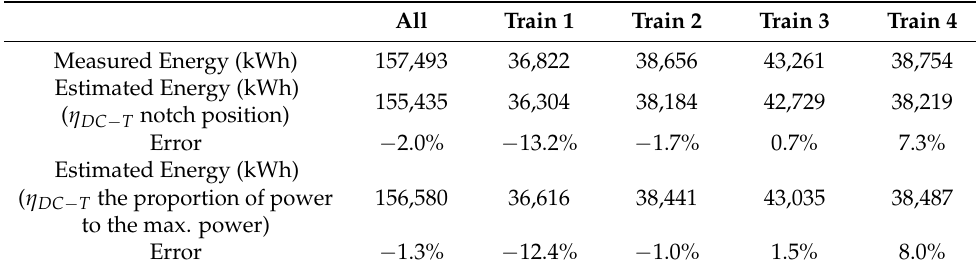
Table 4. Energy consumption model evaluation for individual